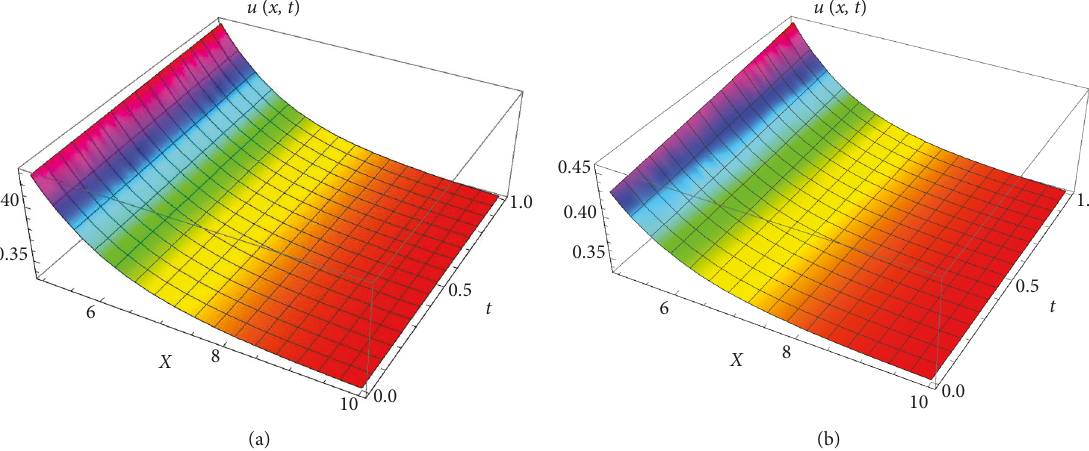
Figure 3: Surface solution between the proximate and the exact solutions w.r.t initial condition (25), when α solution. (b) The exact